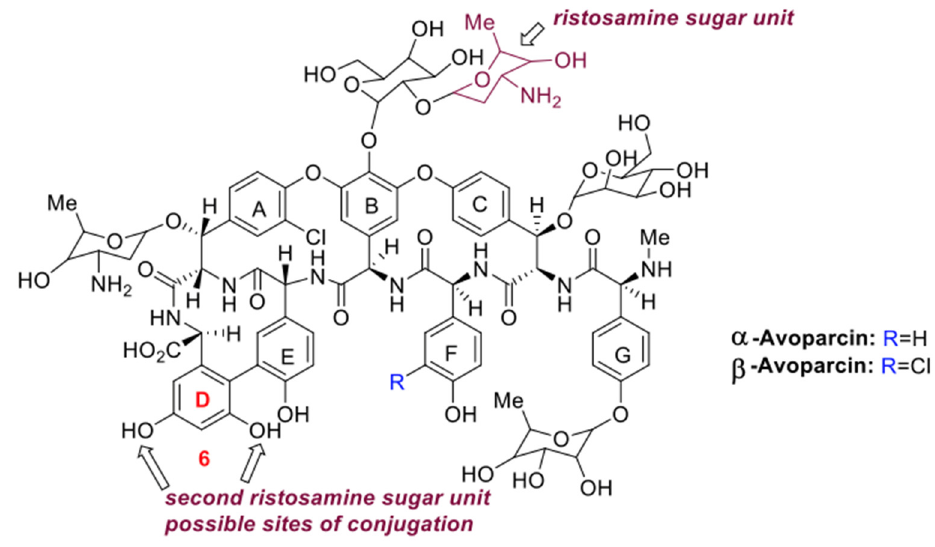
Figure 3. HPLC profile of the agarose D-Ala-D-Ala purified avoparcin complex. (a) α -avoparcin, (c)